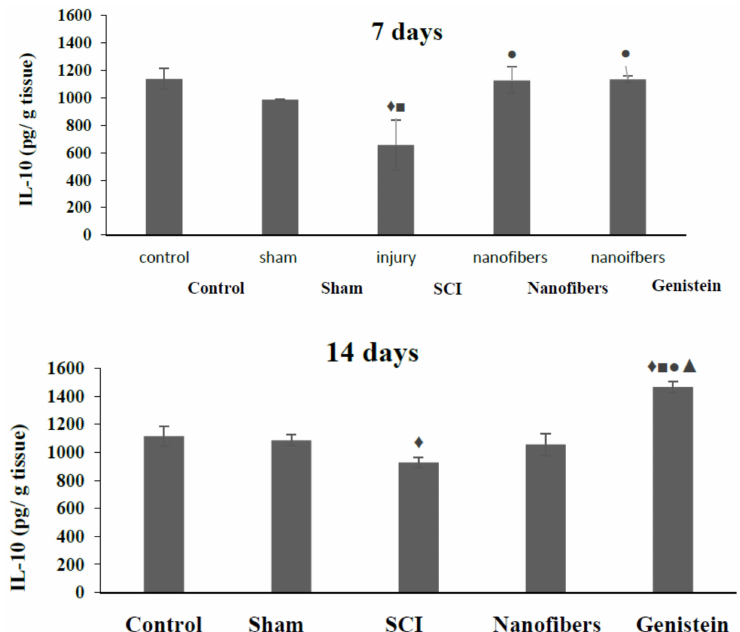
Figure 4. Level of interleukin-10 (IL-10) (pg/g tissue) in spinal cord tissue. Spinal cord injury (SCI) induced a significant ( p < 0.05) decrease in the IL-10 levels in spinal cord tissue at all the time intervals examined when compared with control group ( (cid:7) ). IL-10 levels were also reduced in the injury group at one and seven days compared to the sham group ( (cid:4) ). Nanofibers caused an increase in IL-10 in spinal cord tissue, which was only significant ( p < 0.05) after seven days with respect to SCI group. On the other hand, treatment with genistein nanofibers induced a significant ( p < 0.05) elevation in IL-10 level in spinal cord tissue when compared with SCI group ( ). Moreover, the increase in IL-10 level was more pronounced at 14 days post injury where it was significant ( (cid:78) , p < 0.05) in comparison to the other four groups. Number of animals ( n = 5). (Mean ± S.E.M.).